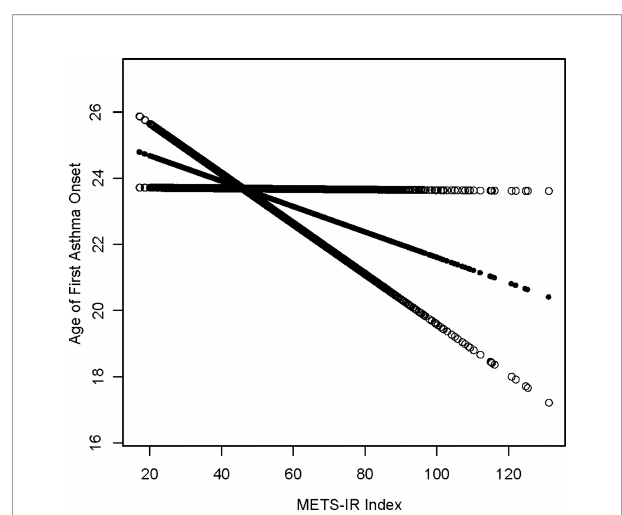
FIGURE 2 | Densitydose-responserelationshipbetweenMETS-IRindexwithonset ageofprevalence.Theareabetweentheupperandlowerdashedlinesisrepresented as95%CI.EachpointshowsthemagnitudeoftheMETS-IRindexandisconnected to form a continuousline. Adjusted for allcovariates except effectmodi fi